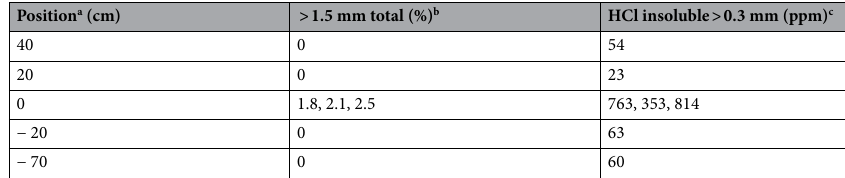
Table 1. Concentration of rock/mineral grains in marls from the Bernhardzell sampling locality (three independently analyzed Blockhorizont samples). a Relative to center of visual ejecta layer with limestone fragments. b Includes limestone fragments. c Concentration (ppm = mg/kg) of HCl insoluble silicate grains > 0.3 mm in diameter in the bulk